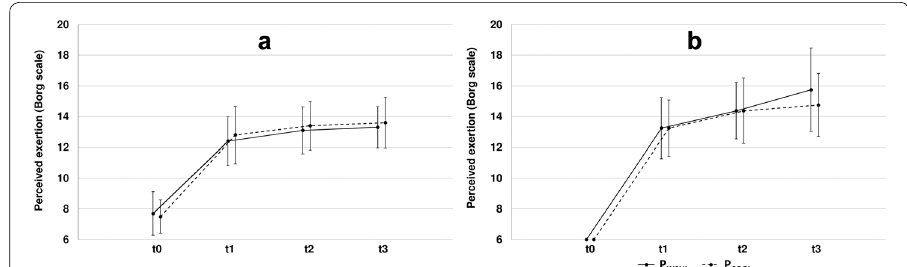
Fig. 7 Perceived exertion as measured after warm-up (t0) and after 15 min (t1), 30 min (t2) and 45 min (t3) of running with the Borg scale for the thermally insulating (P INSUL ) and non-insulating (P COOL ) pants in studies A ( a ) and B ( b ). No significant differences were found between P INSUL and P COOL but factor time was significant in study A and B (p <